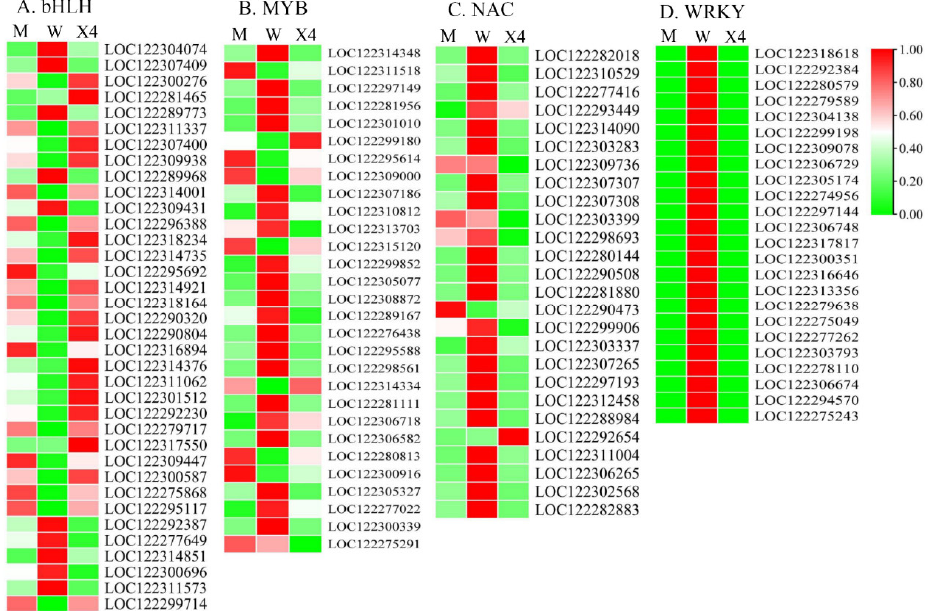
Figure 6. Heat map representing major transcription factor family members that were differentially expressed in fruits of three pecan cultivars: ( A ) bHLH; ( B ) MYB; ( C ) NAC; ( D ) WRKY. Colored boxes indicate genes with high (dark red) and low (dark green) expression.